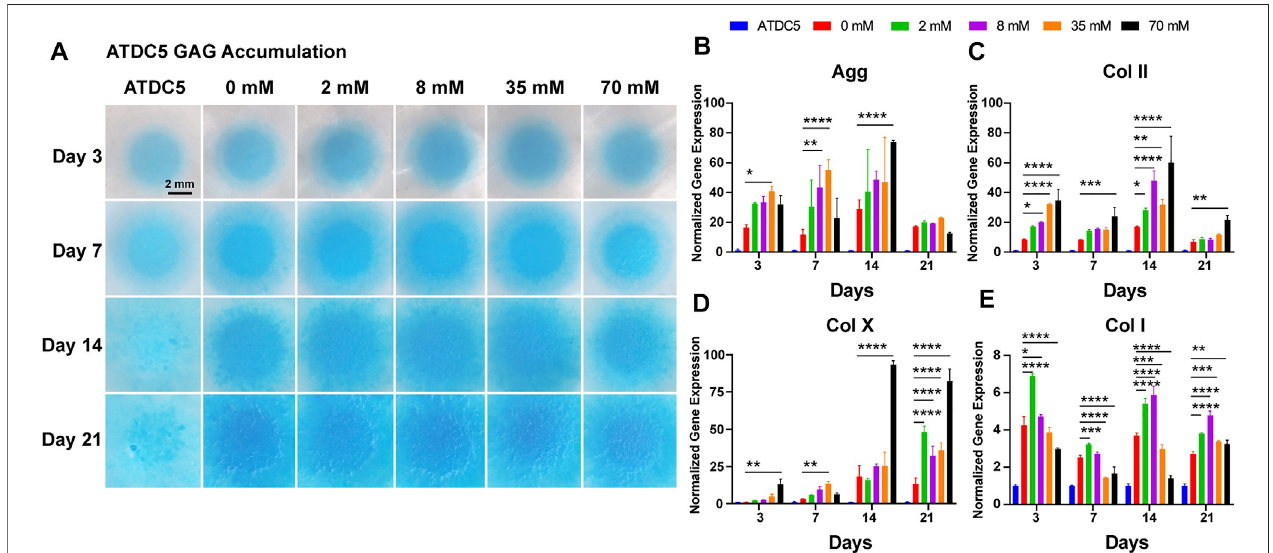
FIGURE 1 | Chondrogenic phenotype of ATDC5. (A) GAG accumulation of ATDC5 with galactose treatment within 21 days. Scale bar = 2 mm. Gene expression analysis of (B) aggrecan, (C) collagen II, (D) collagen X, and (E) collagen I was performed on days 3, 7, 14, and 21. GAPDH was used as a reference gene. The fold